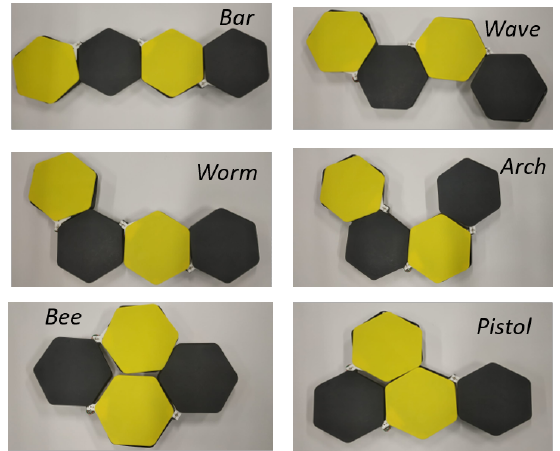
Figure 5. The hHoneycomb platform represents all feasible combination.